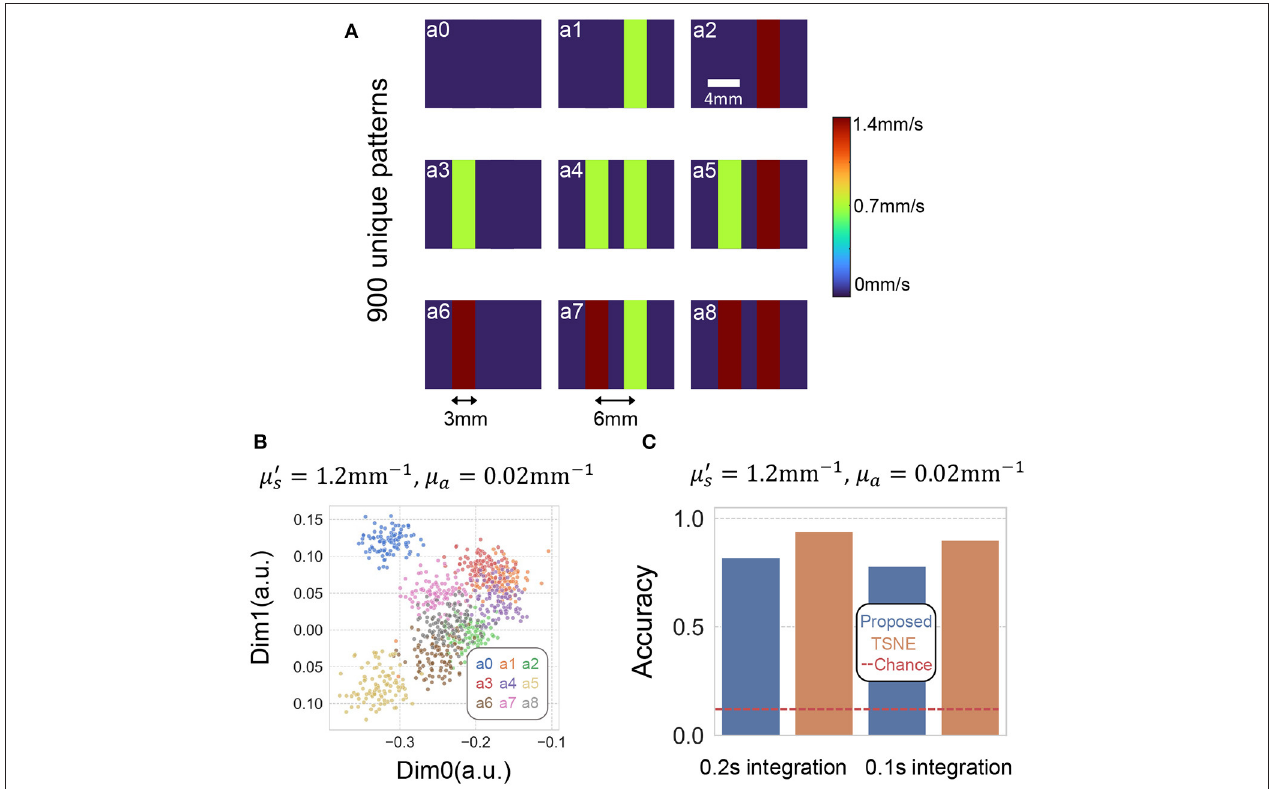
FIGURE 7 | (A) Depicts the nine decorrelation events we attempted to separate. Those events were generated by placing two 3mm diameter tubes filled with scattering volume placed underneath the liquid phantom. The scattering liquid in the tube either did not flow, or flowed at 1.4 and 0.7 mm/s, driven by two syringe pumps. (B) Plots two of the eight dimensions of the embedding using TSNE and proposed method. (C) Barplots of the classification accuracy of TSNE and proposed method using 0.1 and 0.2 s integration time. The red dashed line plots the baseline of chance, which is 0.11 for a nine-category classification